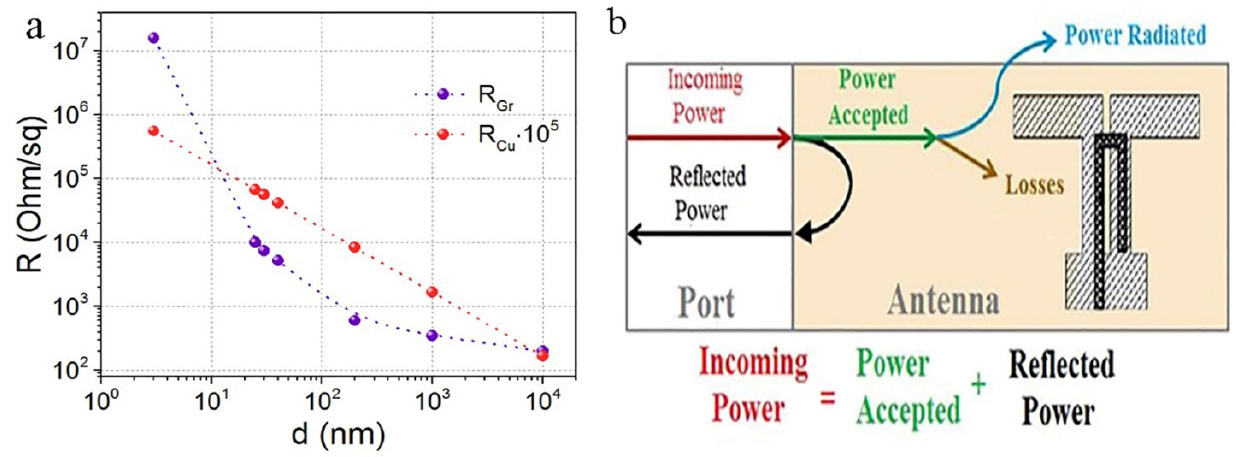
Figure 2. ( a ) An atomic force microscope image of a layer created by screen printing from a graphene suspension. ( b ) Optical image of the graphene suspension strip edge screen-printed onto Kodak photographic paper.